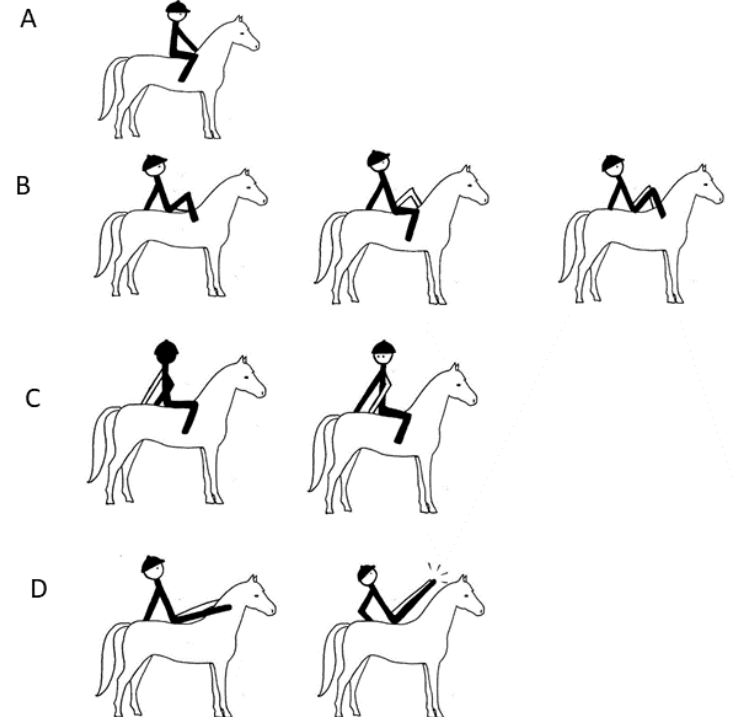
Figure 1. Exercises performed by probands from ( A ) the riding seat position. ( B ) Exercise 1, the elevation of the knees. ( C ) Exercise 2, rotation of the trunk. ( D ) Exercise 3, clapping the lower limbs. See the text for a detailed description. Drawing by Klára Pyšková.